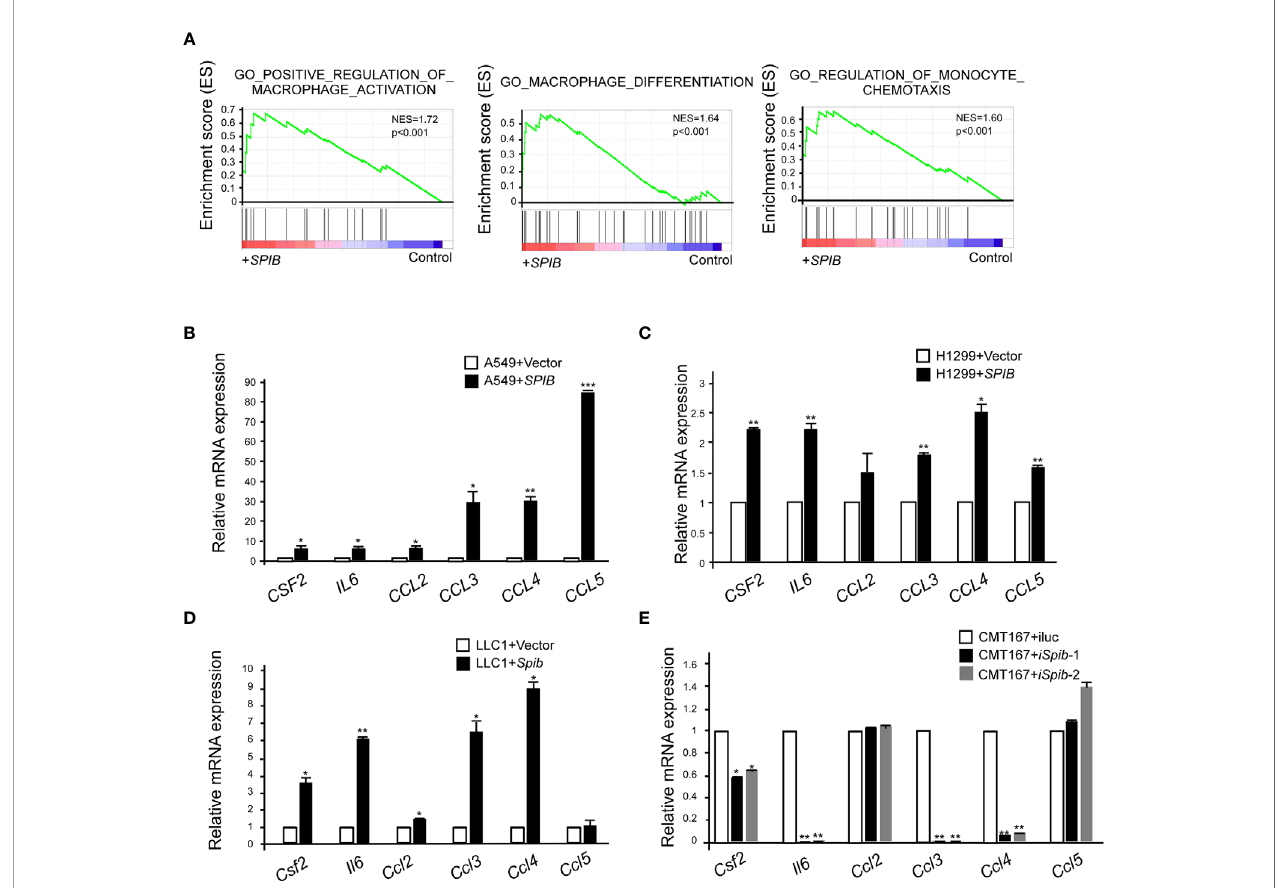
FIGURE 5 | SPIB upregulates the expression of TAM polarization- and recruitment-related genes. (A) GSEA of C5 signatures (positive regulation of macrophage activation, macrophage differentiation, and regulation of monocyte chemotaxis) in microarray data of A549 cells expressing SPIB and control vector. (B – E) Validation of microarray data by RT-qPCR. RNA was puri fi ed from A549 cells expressing SPIB or empty vector (B) , H1299 cells expressing SPIB or empty vector (C) , LLC1 cells expressing Spib or empty vector (D) , and CMT167 cells with knockdown of Spib or control (E) . Mean ± SD. *P < 0.05. **P < 0.01 ***P <